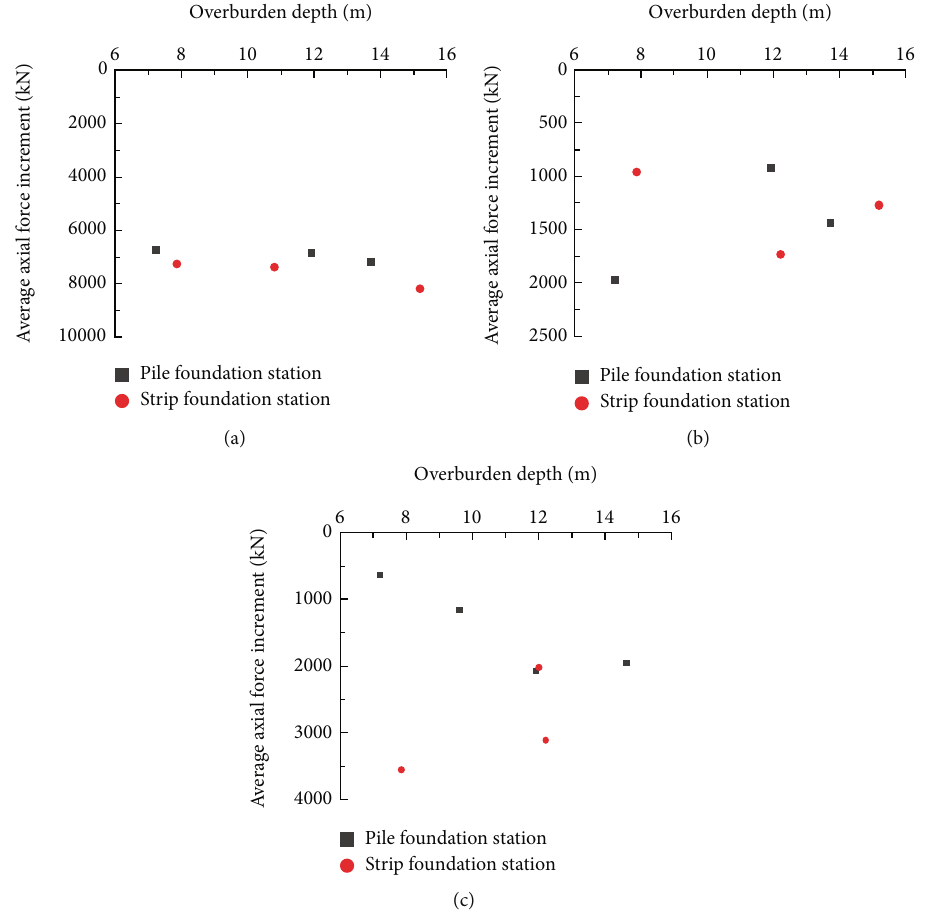
Figure 16: Statistics of the axial force of the steel pipe column in each construction stage: (a) buckle arch stage of the second lining buckle, (b) soil excavation of the station hall, and (c) soil excavation stage of the platform layer.